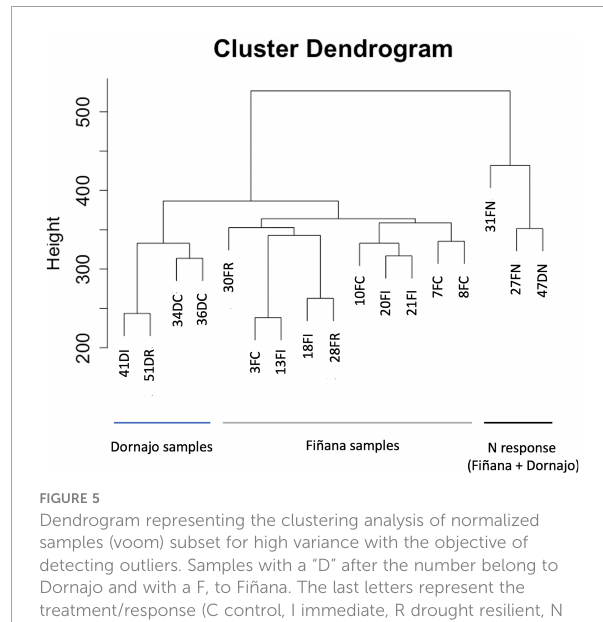
FIGURE 5 Dendrogram representing the clustering analysis of normalized samples (voom) subset for high variance with the objective of detecting outliers. Samples with a “ D ” after the number belong to Dornajo and with a F, to Fiñana. The last letters represent the treatment/response (C control, I immediate, R drought resilient, N